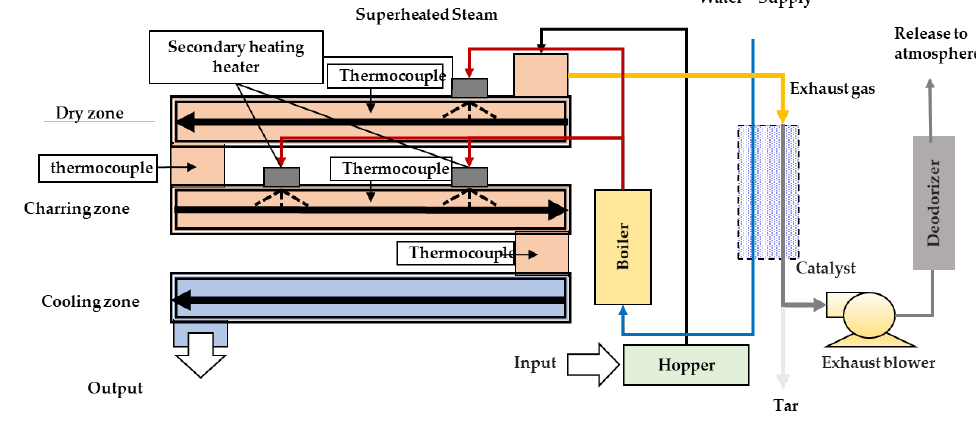
Figure 4. Torrefaction experimental equipment.